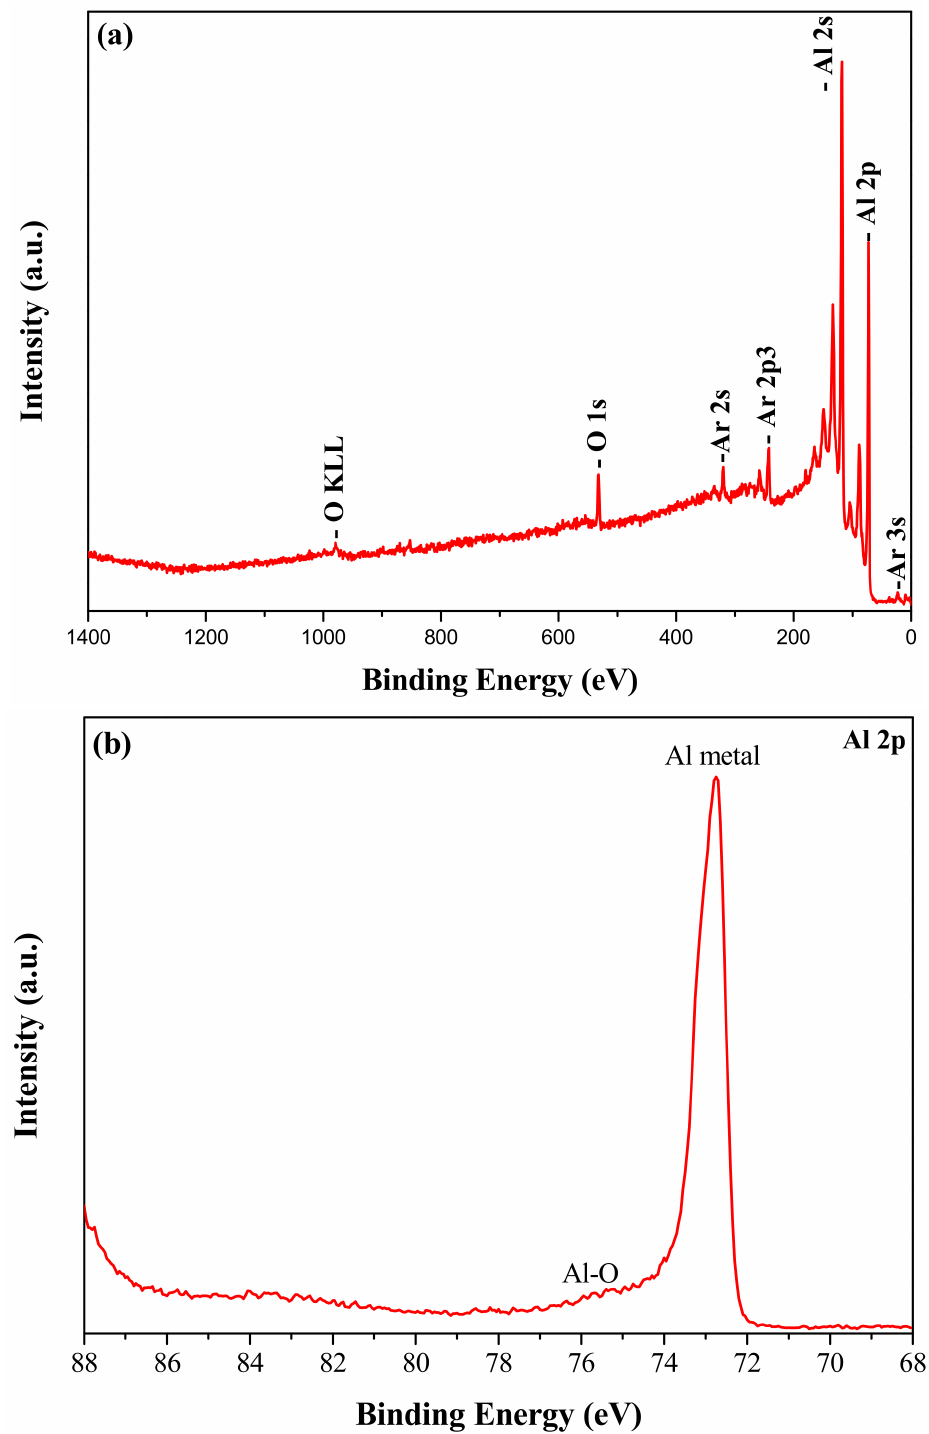
Figure 5. ( a )XPSsurveyspectrumacquiredfromsampleE46after5.7minsputtering. ( b )High-resolutionAl2ppeakafter